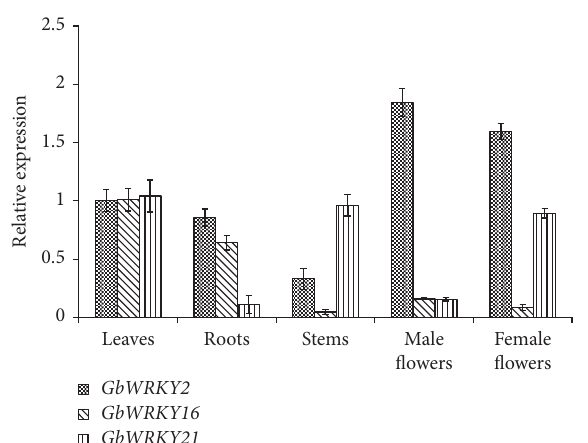
Figure 1: The expression levels of GbWRKY2 , GbWRKY16 , and GbWRKY21 in Ginkgo biloba different tissue. Relative expression levels of GbWRKY2 , GbWRKY16 , and GbWRKY21 in different tissues with GbGAPDH gene as internal reference gene. Total RNA samples were isolated from leaves, roots, stems, male flowers, and female flowers, respectively. Each sample was individually assayed in triplicate. Values shown represent the mean reading from three plants and the error bars indicated the standard errors of the mean.